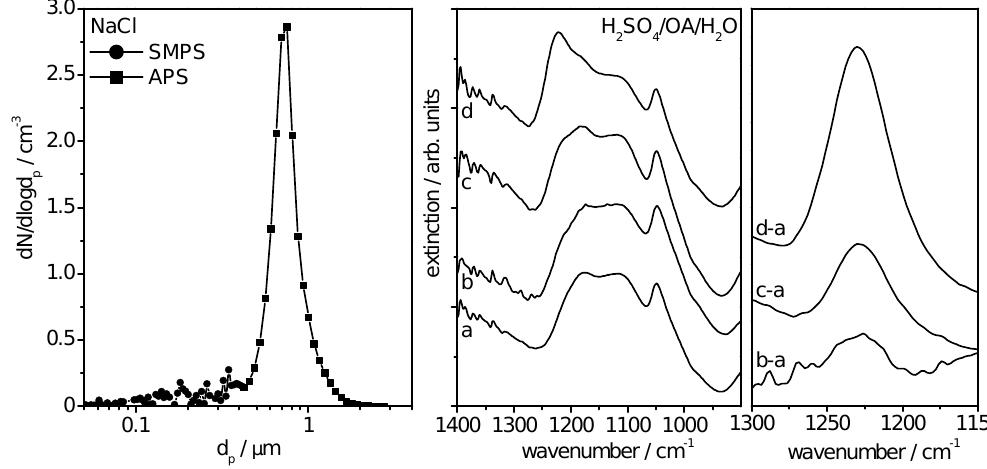
Fig. 3. Left panel: Normalised number size distribution of effloresced NaCl particles from Exp. 1 (Table 1) obtained by combination of SMPS and APS measurements. Middle Panel: Infrared extinction spectra of binary aqueous sulphuric acid solution droplets (Exp. 6, trace a) and three ternary H 2 SO 4 /OA/H 2 O solution droplets with OA to H 2 SO 4 mass ratios of 0.51:5 (trace b, Exp. 7), 1.14:5 (trace c, Exp. 8), and 3.43:5 (trace d, Exp. 9), recorded after spraying the respective aqueous solutions into the AIDA chamber at about 265K and 90% RH. The spectra are offset for clarity. Right panel: Difference spectra of the traces b, c, and d shown in the middle panel in relation to spectrum a in the regime of the C–O stretching mode of aqueous oxalic acid (enlarged y-axis compared to the middle